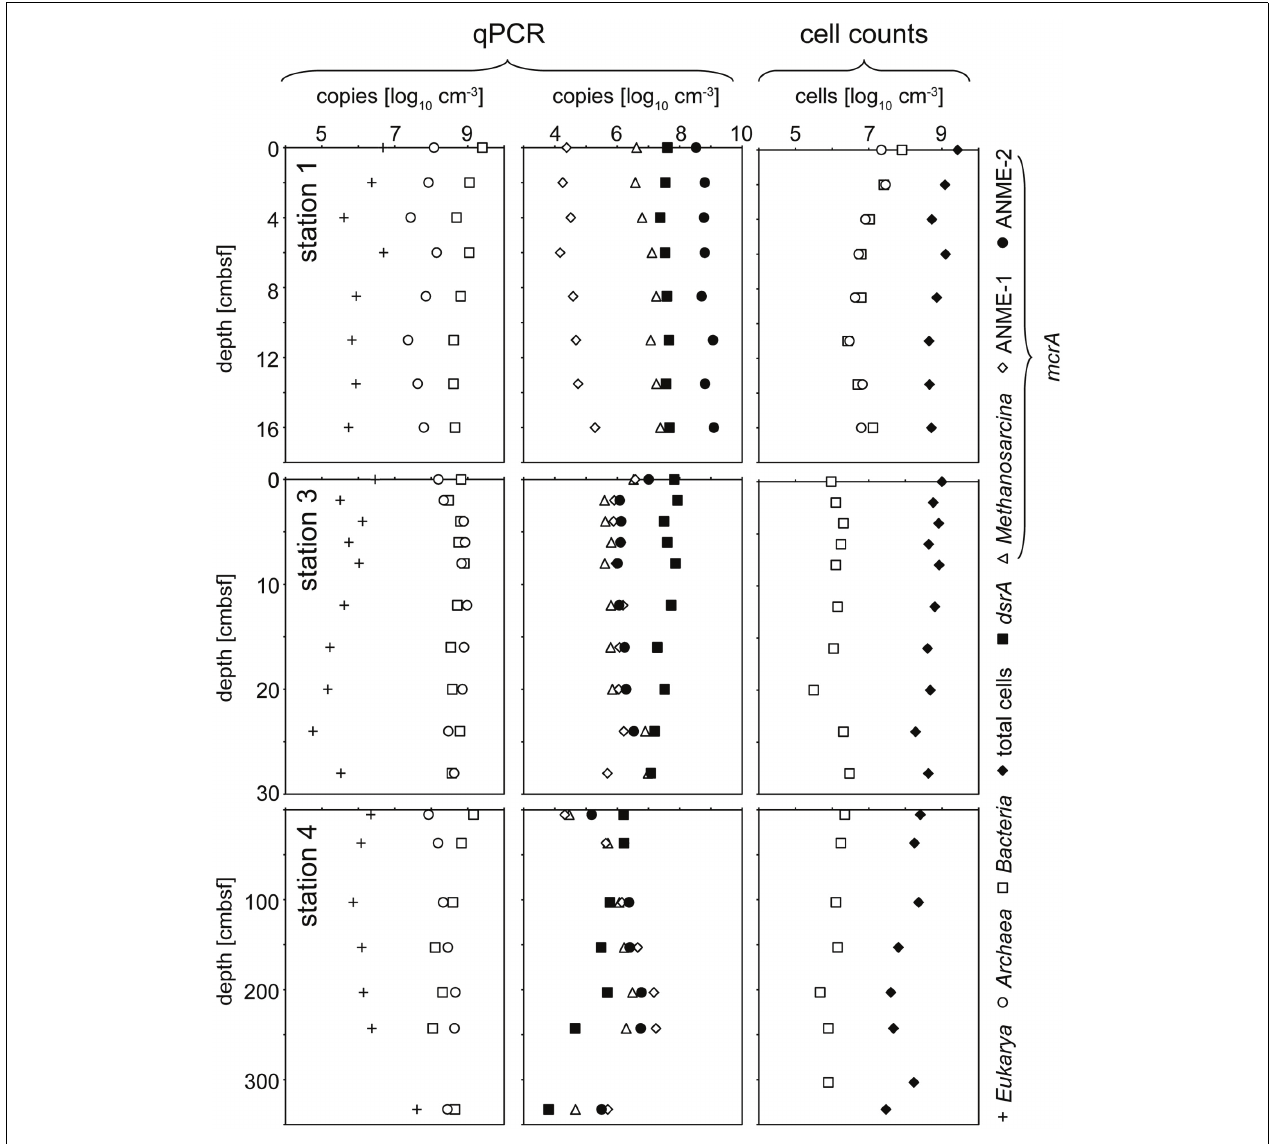
respectively.The middle panel gives an overview over the distribution of the functional gene numbers. In the right panel, total cell counts are compared to CARD–FISH cell counts for Bacteria and Archaea detecting active